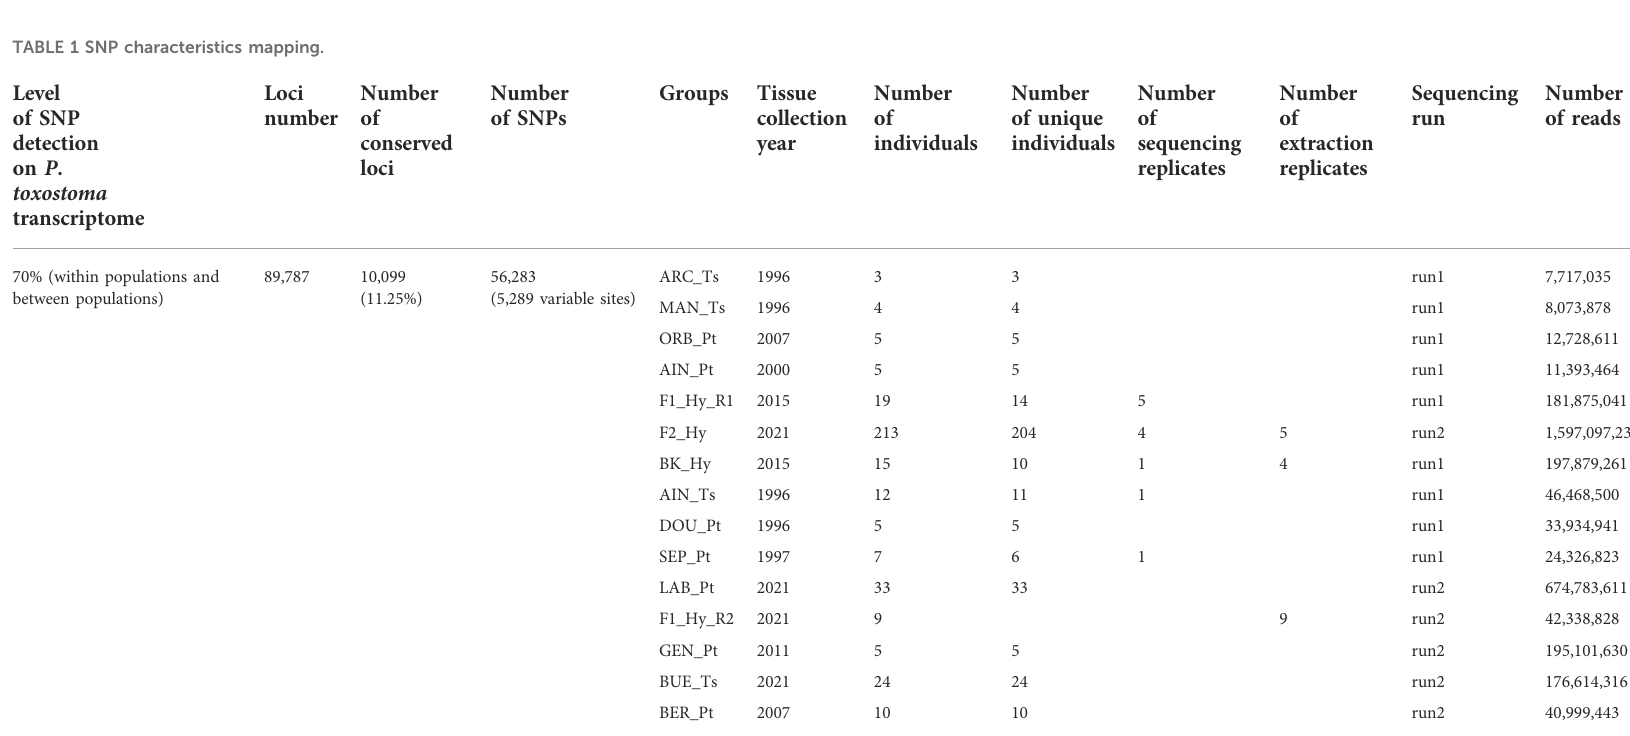
TABLE 1 SNP characteristics mapping. Level of SNP detection on